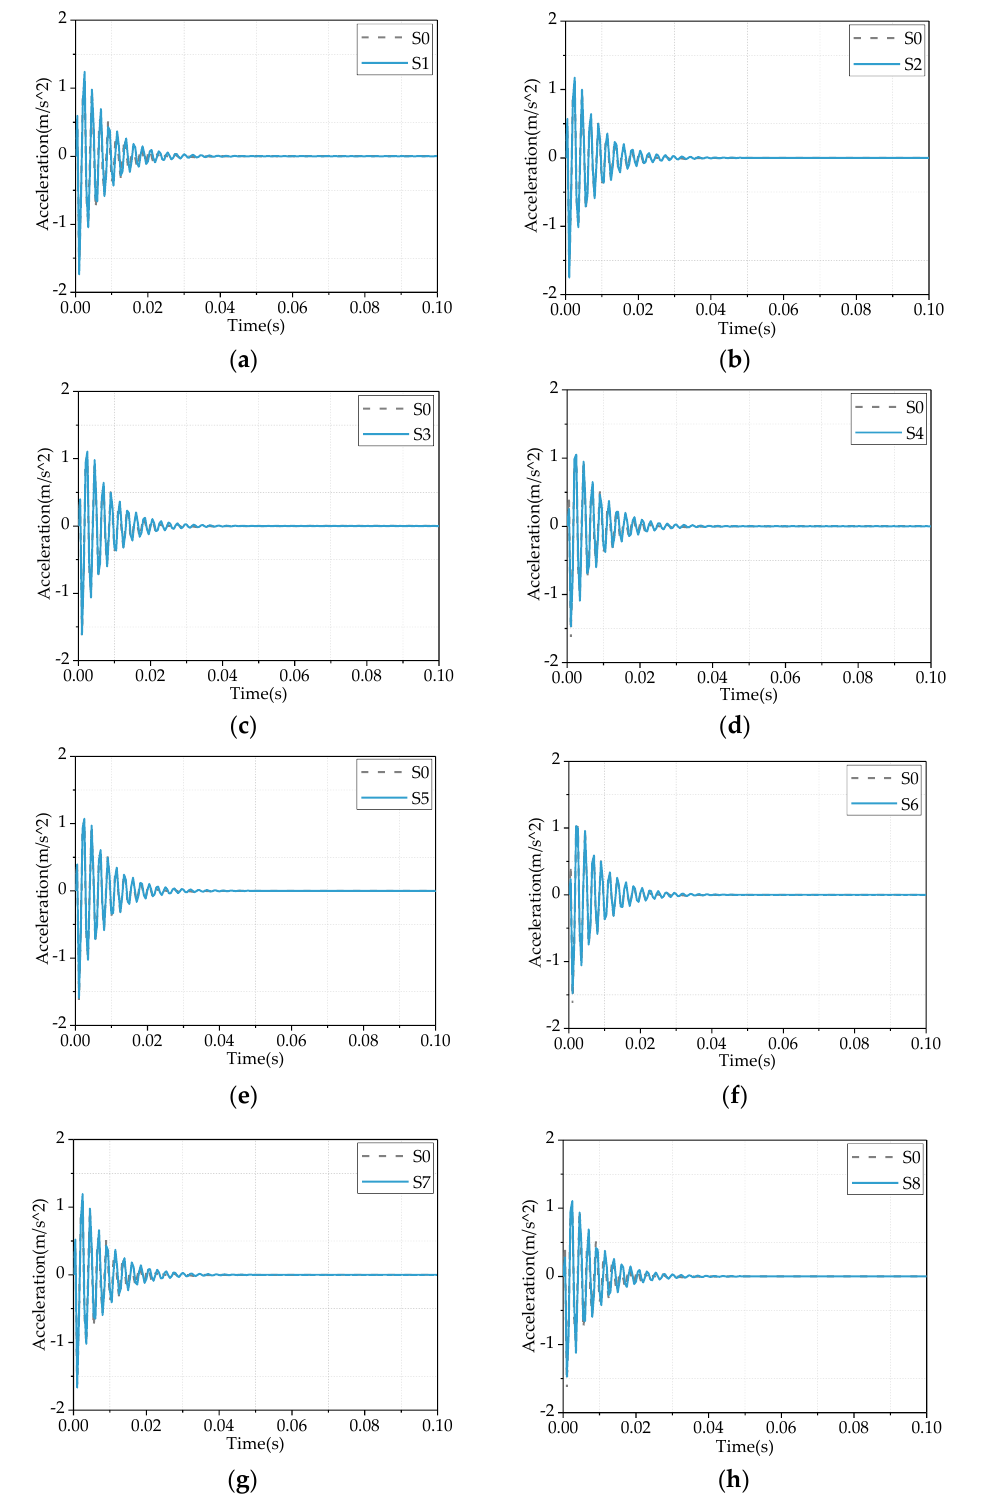
Figure 6. Acceleration response signals of intact structure and damaged structure. ( a ) Working scenarios S0 and S1. ( b ) Working scenarios S0 and S2. ( c ) Working scenarios S0 and S3. ( d ) Working scenarios S0 and S4. ( e ) Working scenarios S0 and S5. ( f ) Working scenarios S0 and S6. ( g ) Working scenarios S0 and S7. ( h ) Working scenarios S0 and S8.